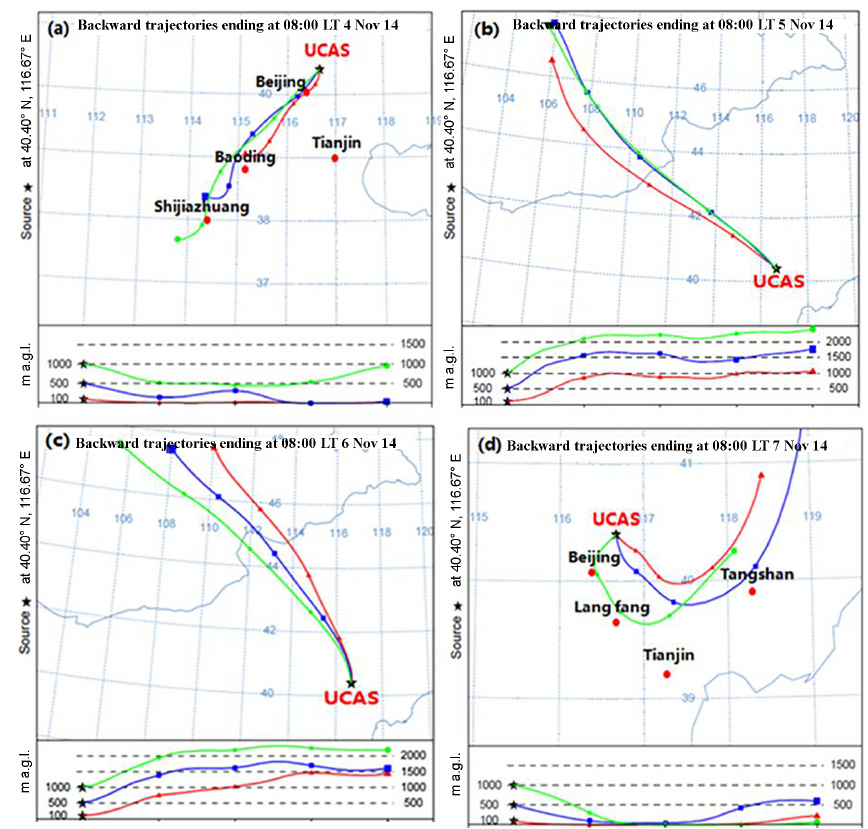
Figure 9. Backward trajectories determined by the HYSPLIT model at UCAS on (a) 4, (b) 5, (c) 6, and (d) 7 November 2014.